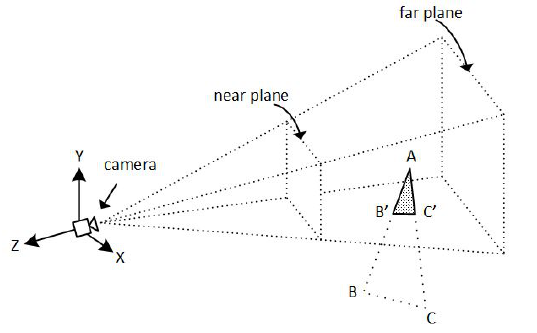
Figure 7. A frustum-shaped clipping region is computational expensive.